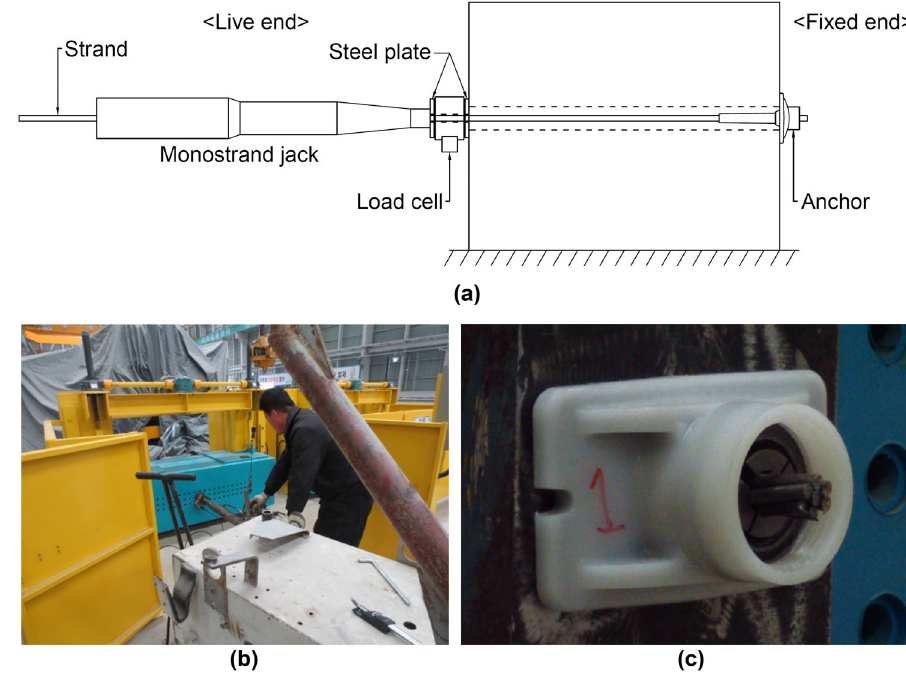
Fig. 6 Setup of jacking test. a Section view, b jacking process at live end, and c fixed end.